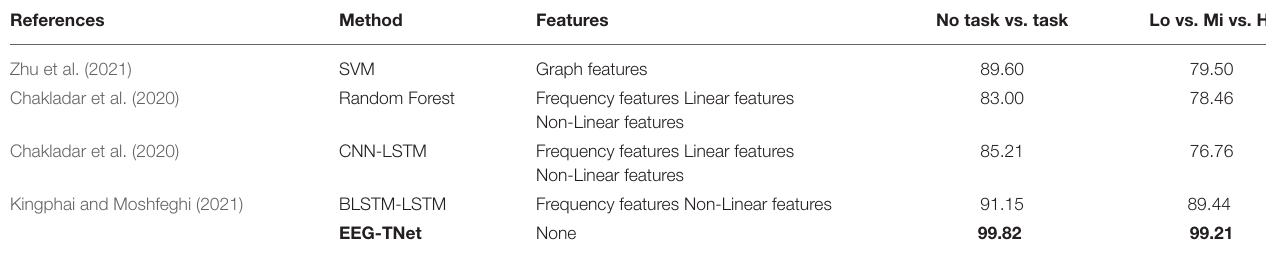
TABLE 2 | Comparisons of the estimation accuracy (%) of subject-dependent experiments among the various